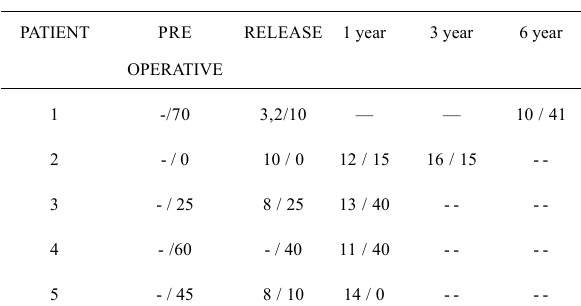
Table 2. Echocardiographic control Pulmonary valvar ring (mm) / Right ventricle